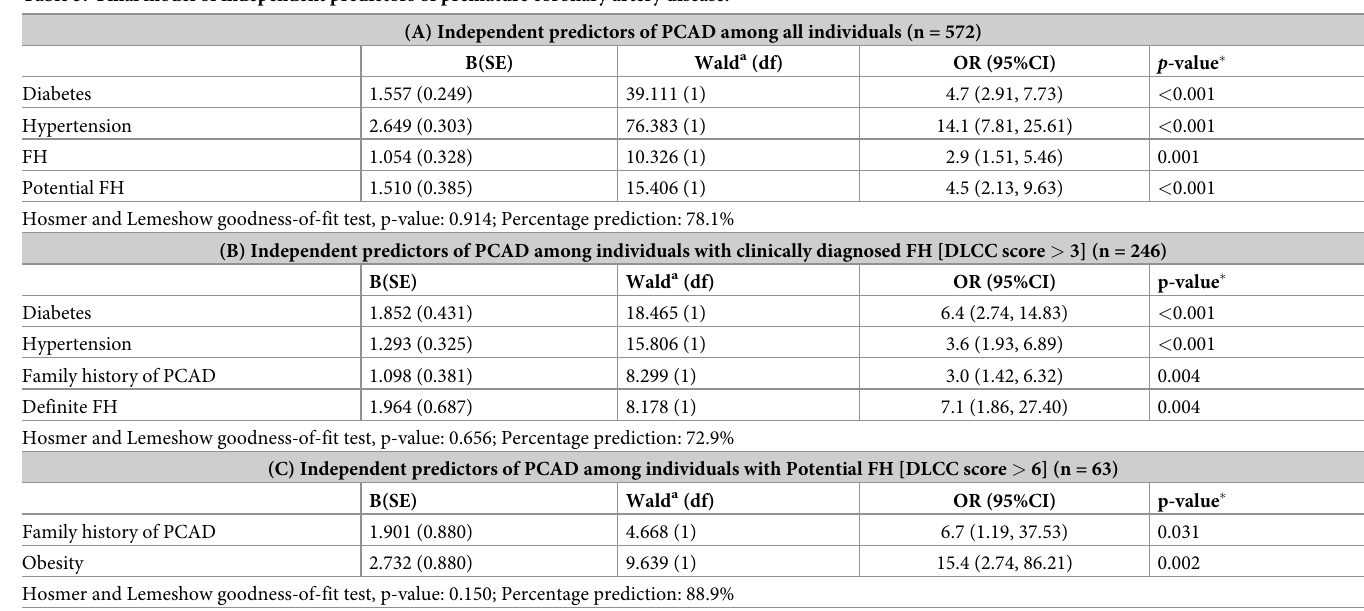
Table 5. Final model of independent predictors of premature coronary artery